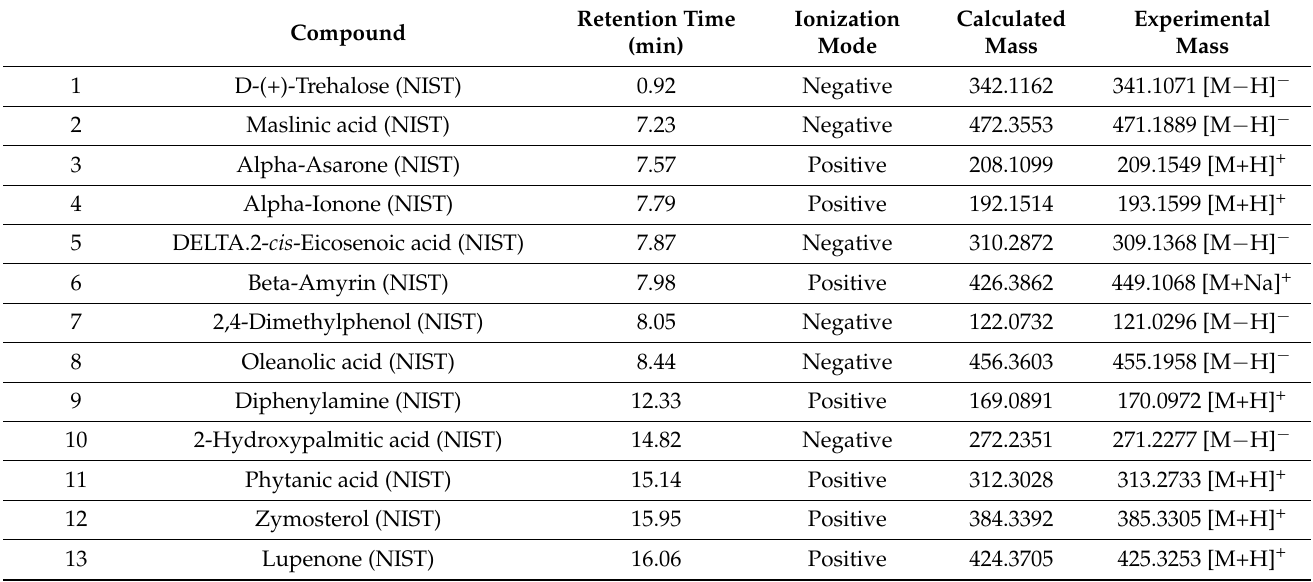
Table 3. LC-MS analysis of methanolic extract of O. baccatus